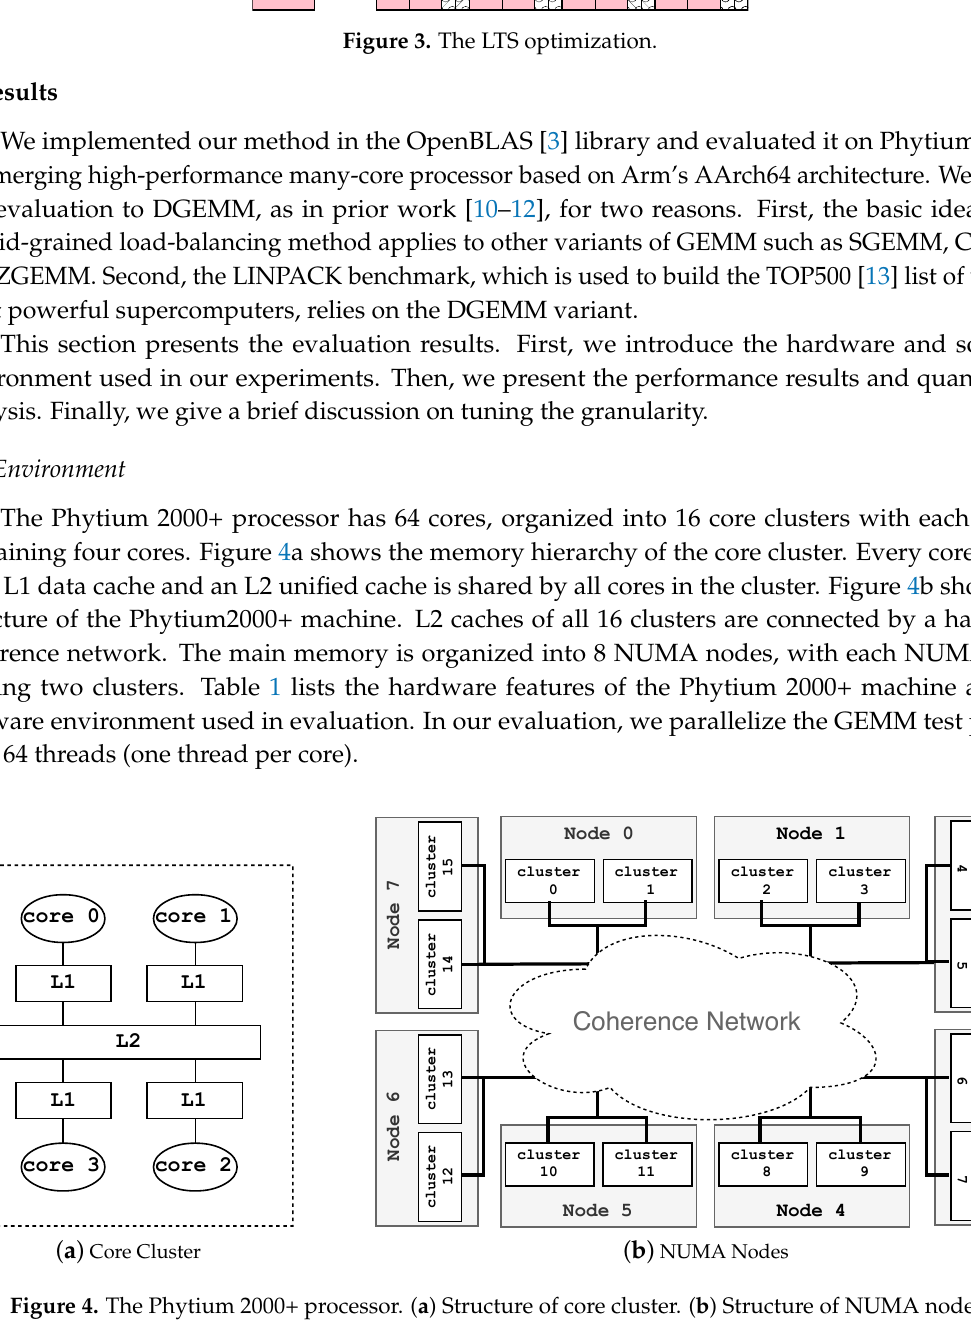
Figure 4. The Phytium 2000+ processor. ( a ) Structure of core cluster. ( b ) Structure of NUMA